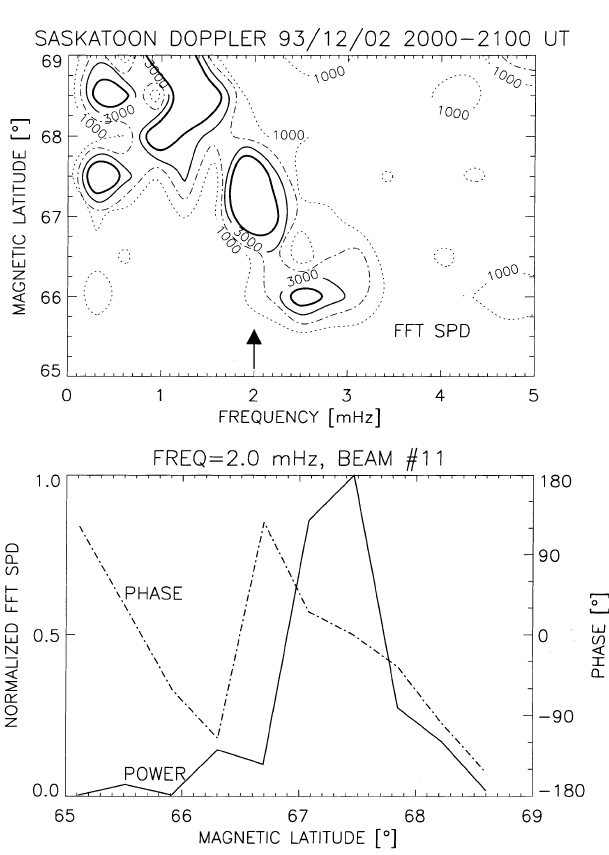
Fig. 13. Contour plots of 32-point fast Fourier transform (FFT) power spectra ( top panel ) of the line-of-sight velocity time series at several range gates for beam 11 of Saskatoon SuperDARN radar. Also, latitude profiles of the spectral power and phase at 2 mHz are shown ( bottom panel